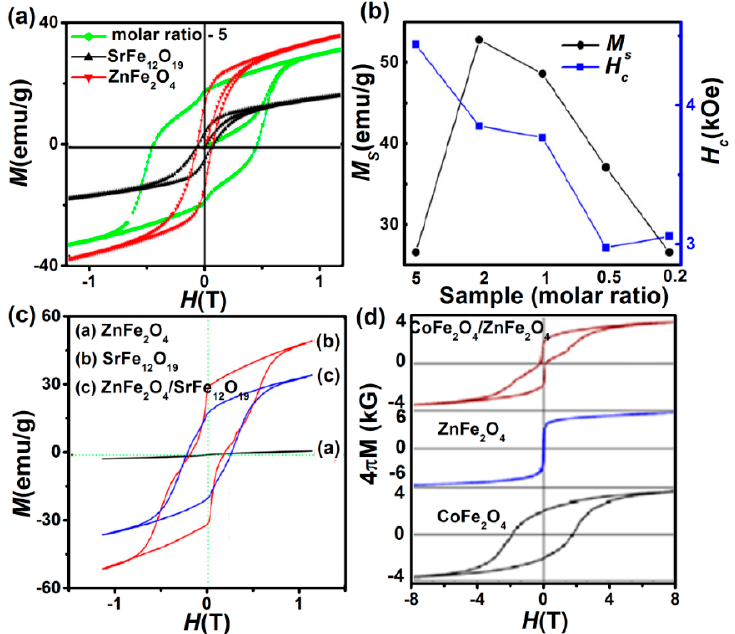
Figure 10. ( a ) M-H loops of SrFe 12 O 19 /ZnFe 2 O 4 with molar ratio 5 (Reproduced with permission from [61]. Copyright Elsevier, 2018). ( b ) Variation of Ms and Hc values with molar ratio changing from 5 to 0.2. ( c ) M - H loops of SrFe 12 O 19 /ZnFe 2 O 4 with normal structured ZnFe 2 O 4 (Reproduced with permission from [62]. Copyright Elsevier, 2013). ( d ) M-H loops of exchange-coupled CoFe 2 O 4 /ZnFe 2 O 4 bilayer at 10 K (Reproduced with permission from [60]. Copyright AIP Publishing, 2013).